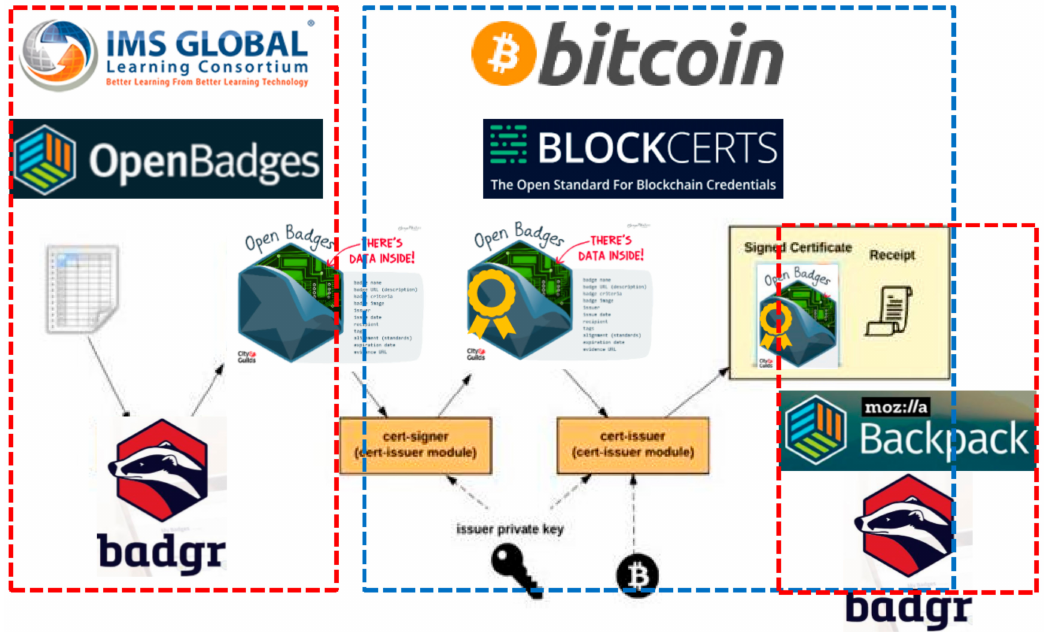
Figure 5. Digital badge issuing process on our system